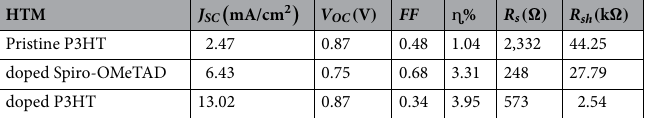
Table 1. experimental J-V parameters of champion devices with three different HTMs.